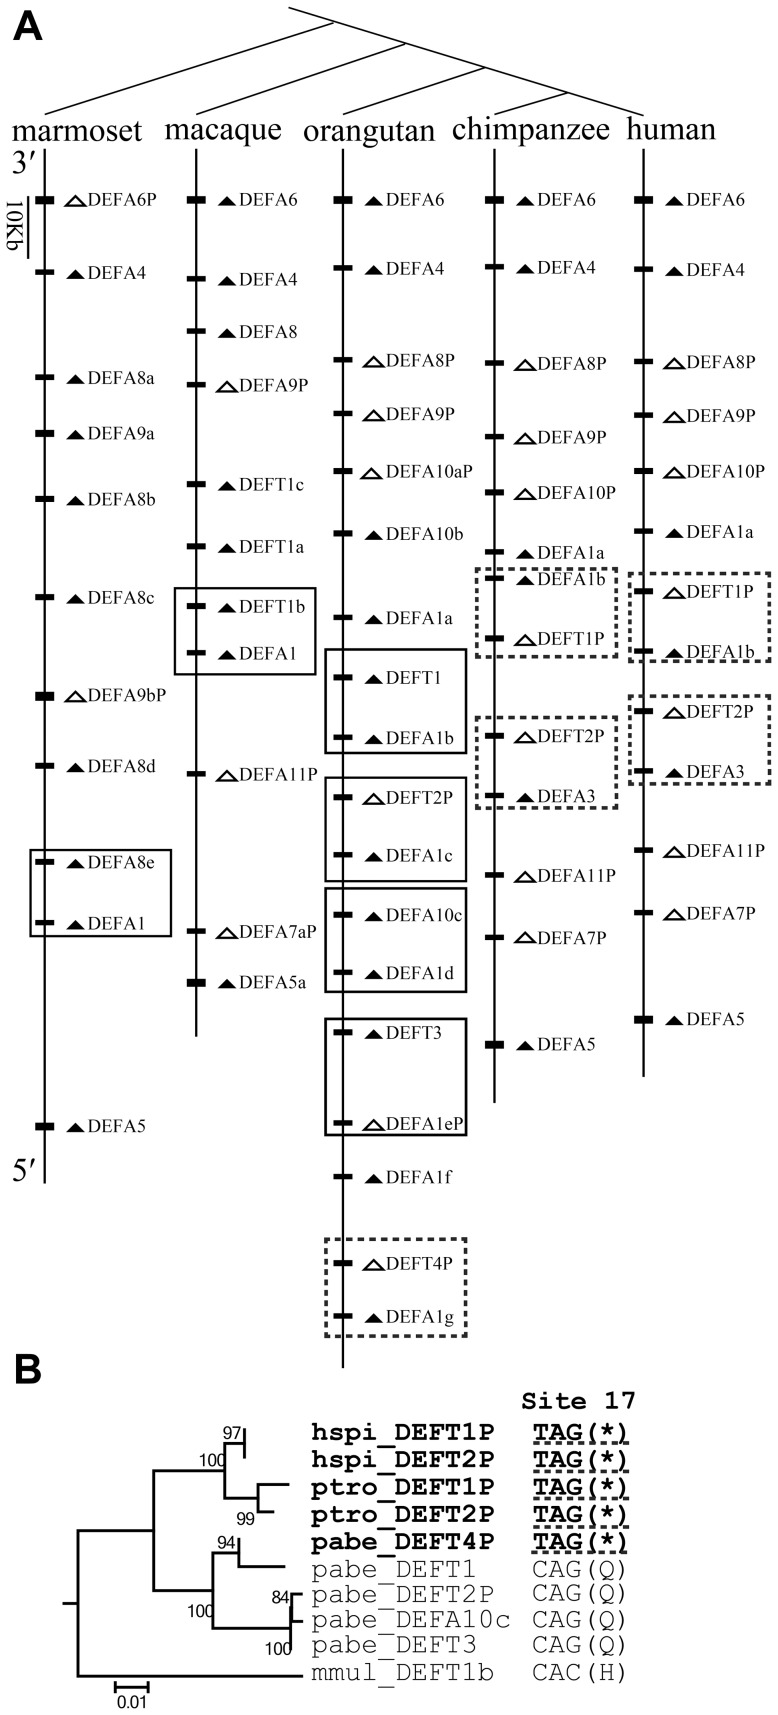
Hitchhiking of DEFT/DEFTP during the birth-and-death evolution of the primate DEFA/DEFT multigene family.A: Comparative synteny map of the DEFA/DEFT gene loci in humans, chimpanzees, orangutans, macaques and marmosets. The boxes highlight the two genes that are linked and duplicate together, including a driver from the DEFA1 cluster and a hitchhiker from the DEFT/DEFA10 cluster. Arrowheads indicate transcriptional orientation. Pseudogenes are in white, and functional genes are in black. The dashed-line box includes the pseudogene DEFTP containing the nonsense mutation at site 17. B: The NJ tree based on the introns of the boxed DEFT/DEFTP from humans (hspi), chimpanzees (ptro), orangutans (pabe) and macaques (mmul). The nonsense mutations (*) at codon site 17 of the pseudogenes hspi_DEFT1P, hspi_DEFT2P ptro_DEFT1P, ptro_DEFT2P and pabe_DEFT4P are underlined with dashed lines, suggesting that these DEFTP pseudogenes are derived from a common ancestor.